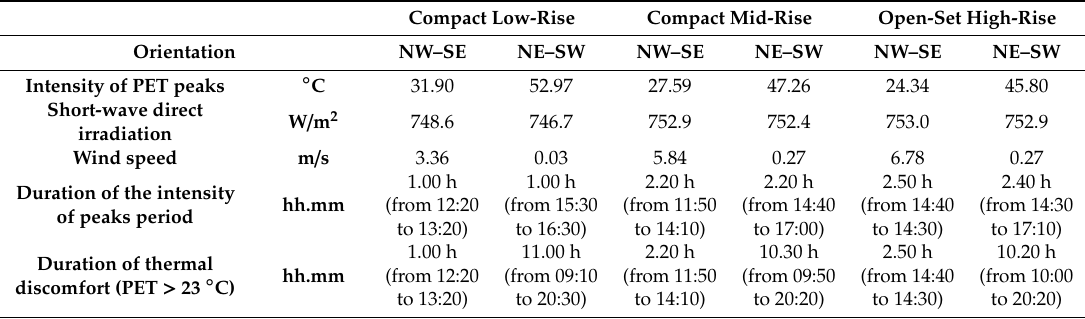
Table 11. Comparison of the PET peaks’ values, Sw, W s , the duration and the intensity of PET peaks and the duration of thermal discomfort between the orientation with the highest (NE–SW) and the lowest (NW–SE) PET values (data corresponds to the receptor R04 with pavement in red brick stones).